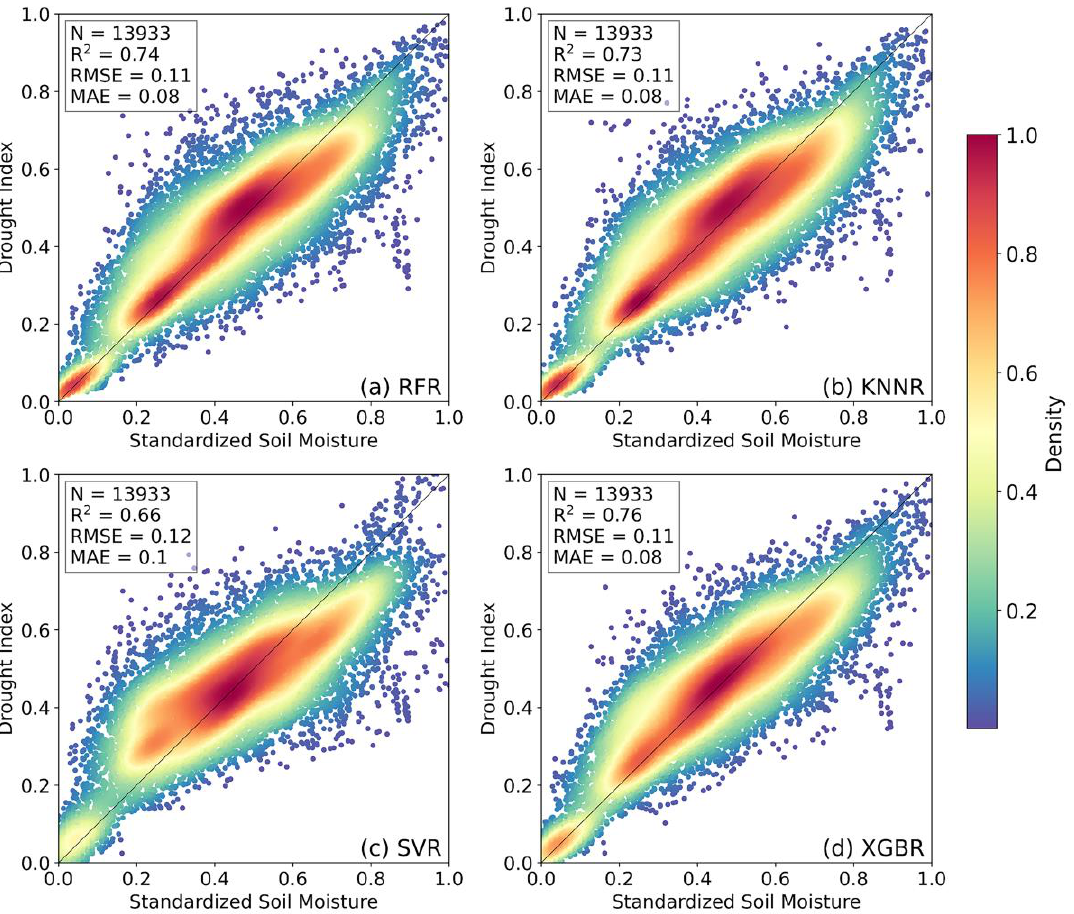
Figure 4. Comparisons of drought indices using four machine learning models with the in situ soil moisture in the validation process: ( a ) RFR, ( b ) KNNR, ( c ) SVR, and ( d ) XGBR. Colors represent data density: the redder the color, the larger the data density is.